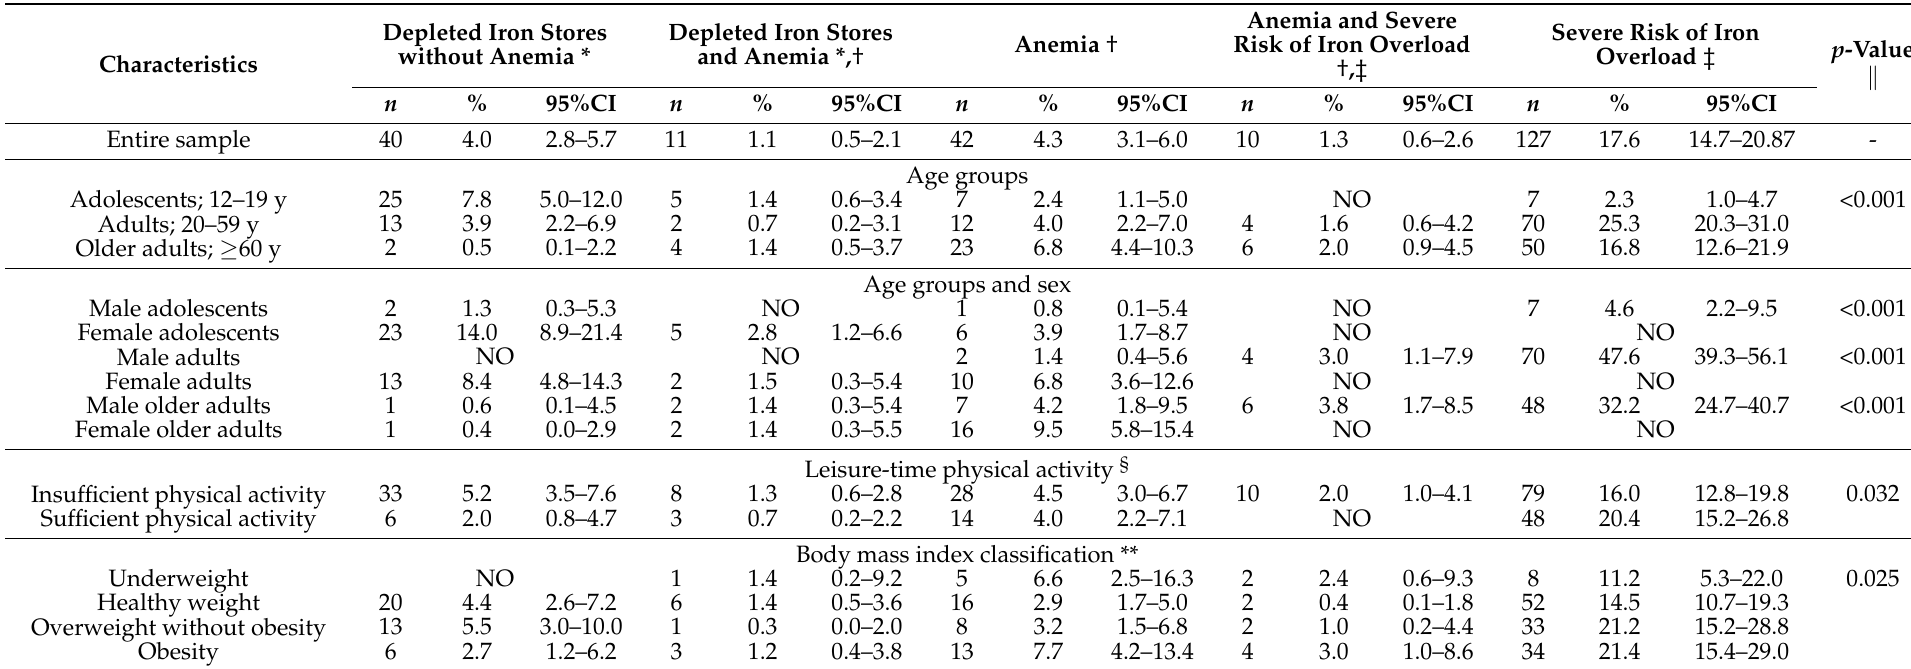
Table 2. Anemia vs. iron stores among residents of the urban area of S ã o Paulo: 2015 Health Survey of S ã o Paulo.